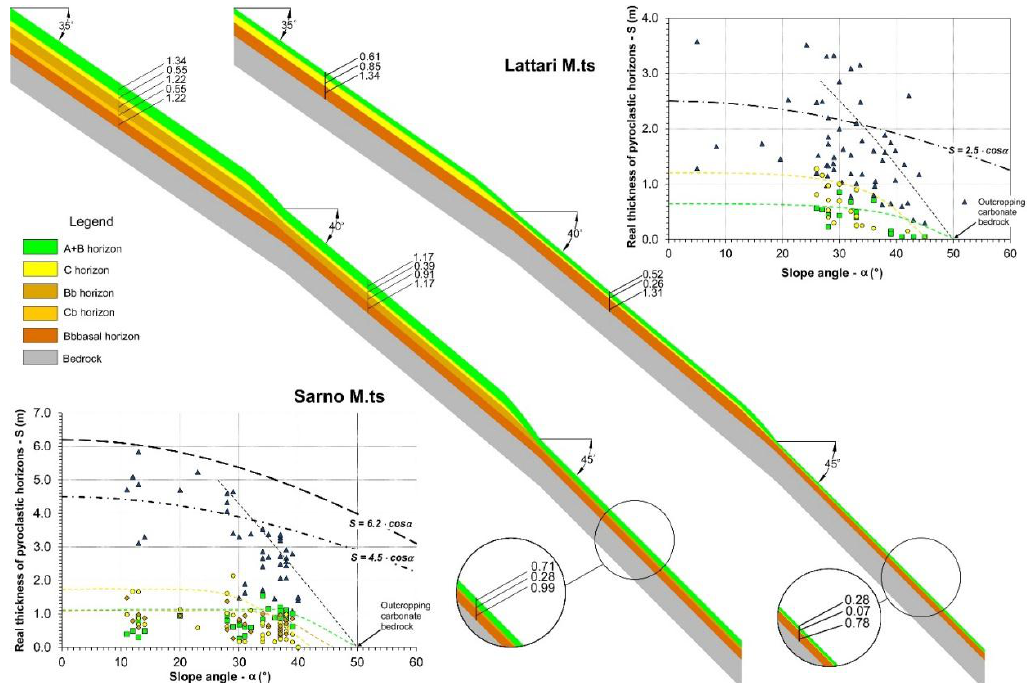
Figure 4. Physical slope models of the Sarno and Lattari Mountains, reconstructed for slope angle values of 35°, 40°, and 45° by empirical relationships (see charts in the opposite corners) between the thicknesses of the whole pyroclastic fall soil mantle (blue triangles) and single soil horizons (dots in other colors). Table 2. Unsaturated hydraulic and mechanical parameters considered for the VS2DTI hydrological modeling [39].